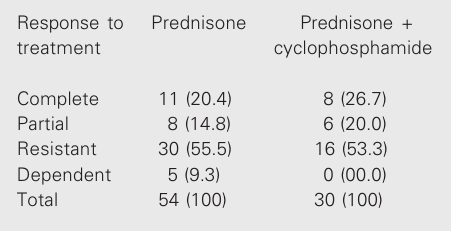
Table 2. Response to treatment of nephrotic syn- drome with immunosuppressive agents.